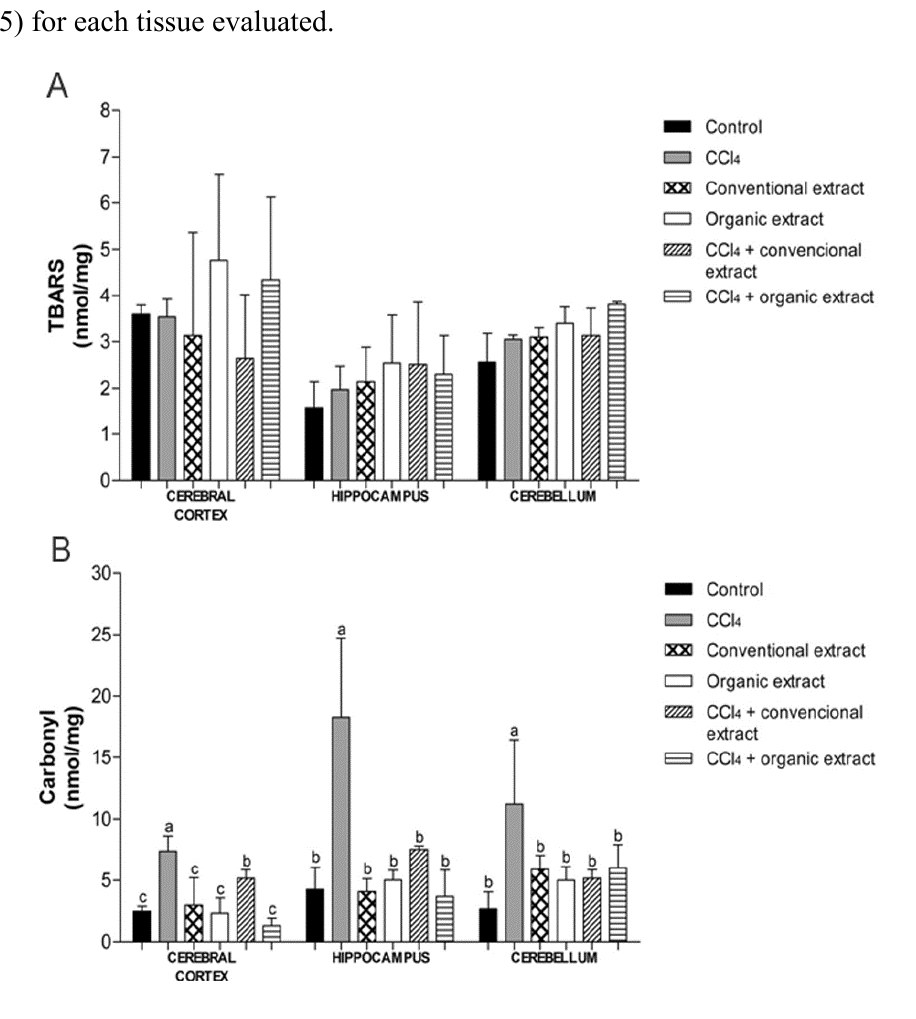
Figure 1. ( A ) Levels of thiobarbituric acid reactive species (TBARS) (nmol/mg) and ( B